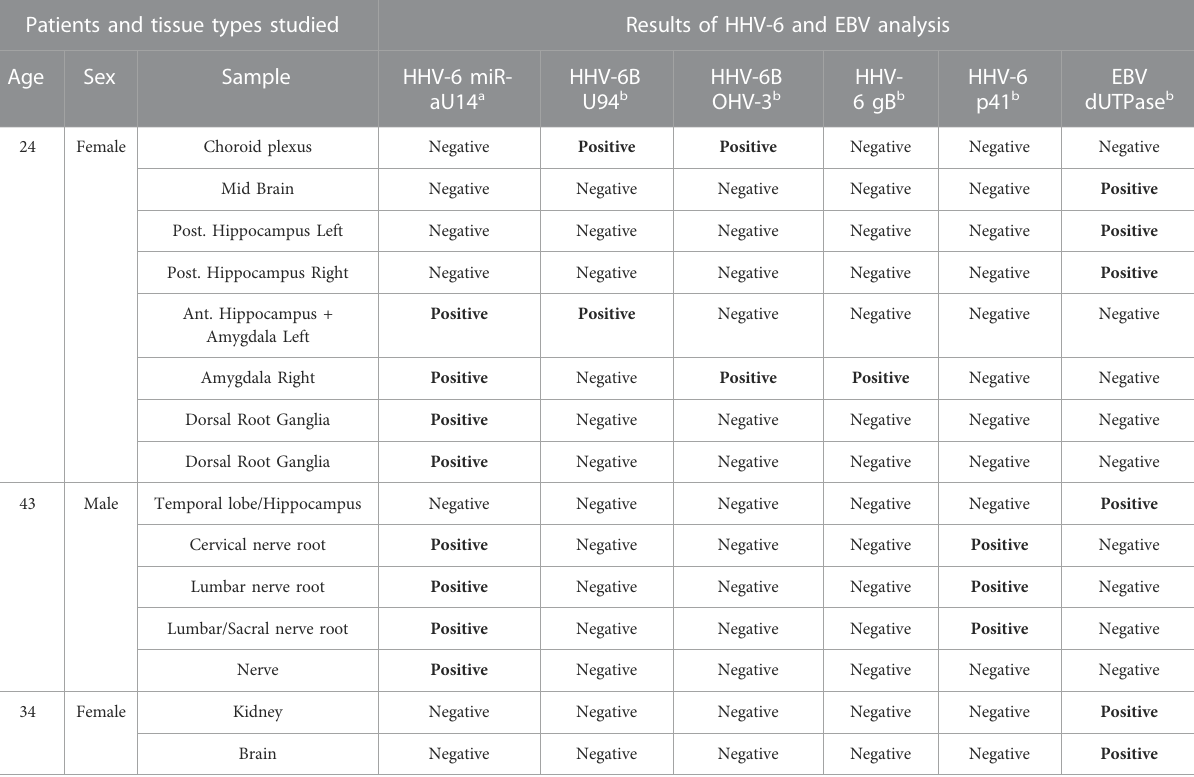
TABLE 1 ME/CFS Patients with HHV-6 and EBV positive samples. Patients and tissue types studied Results of HHV-6 and EBV analysis